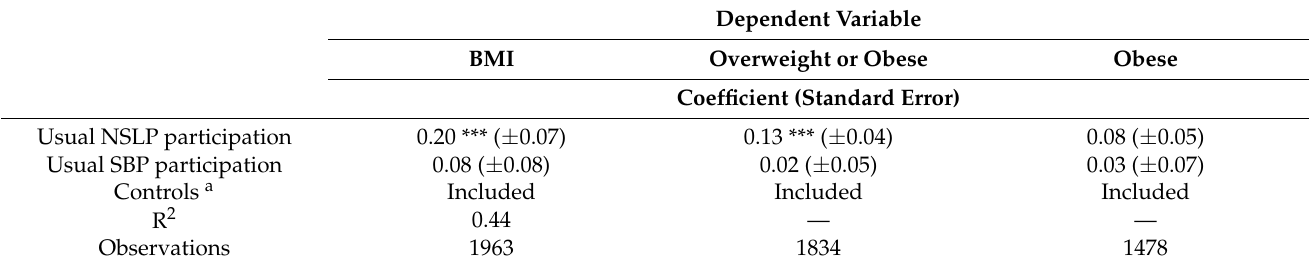
Table A3. Estimated association between SBP and NSLP participation on BMI,